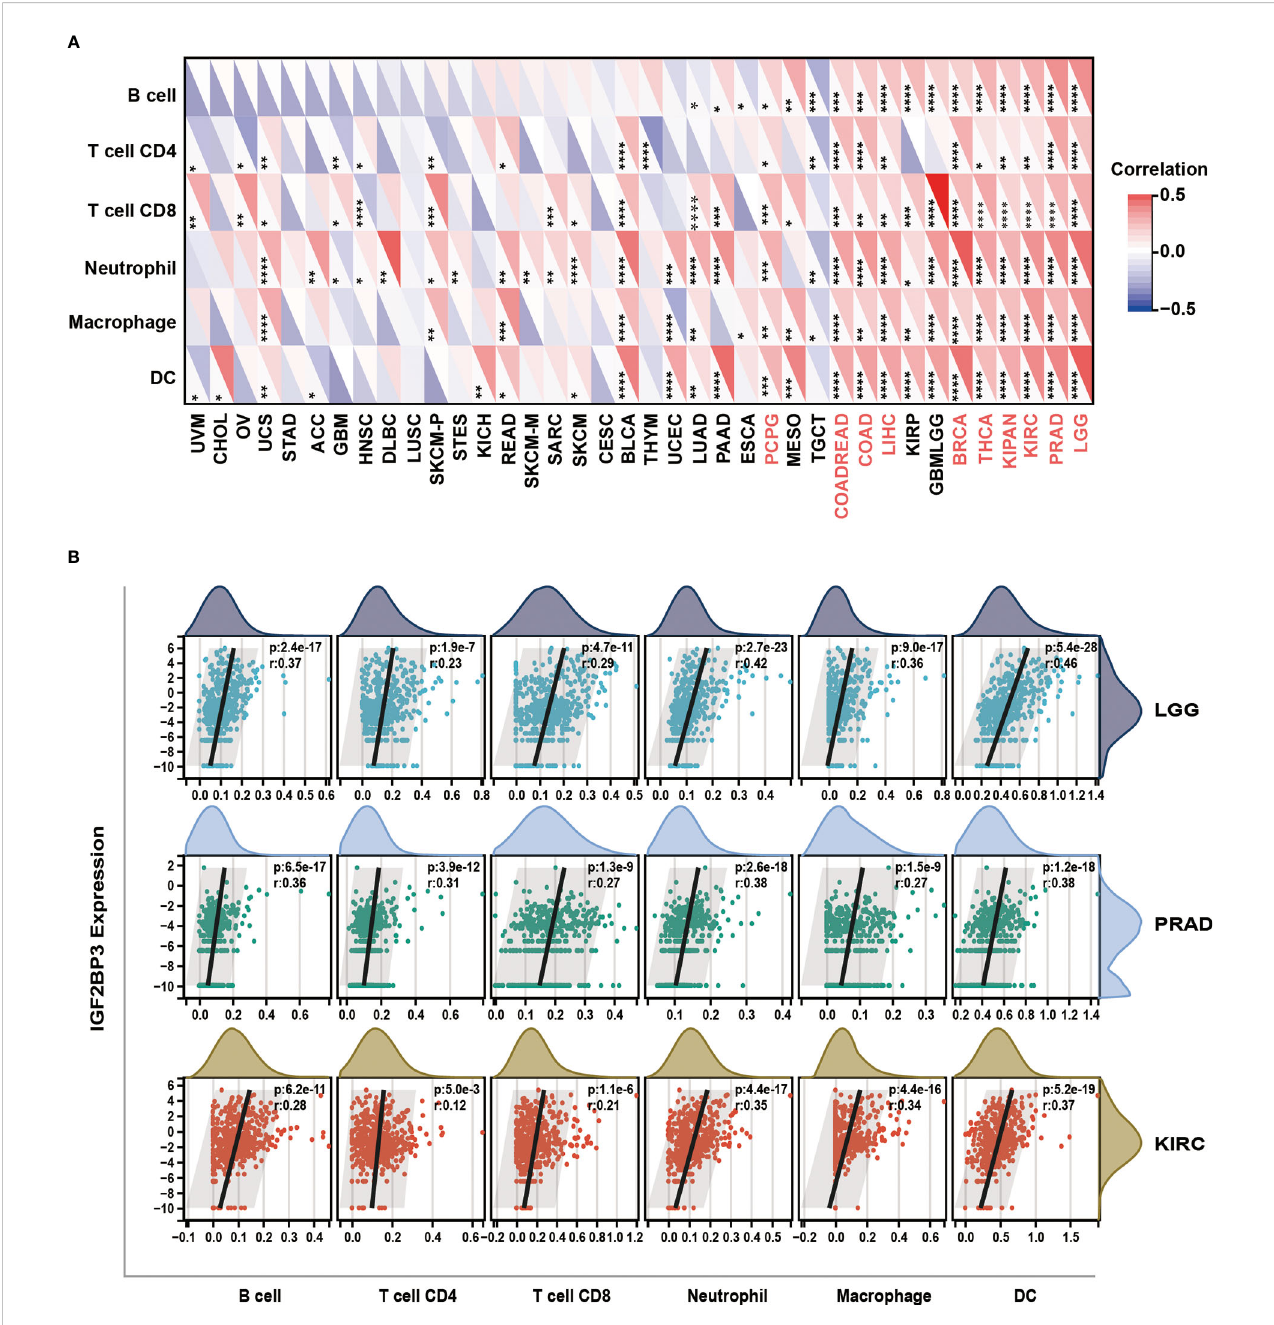
FIGURE 9 Relationship of IGF2BP3 expression with Immune cell in fi ltration analysis. (A) The relationship between IGF2BP3 expression levels and the levels of in fi ltration of six immune-related cells based on TIMER database. (B) Analysis of immune-associated cells in fi ltration with IGF2BP3 expression in pan-cancer. p ≥ 0.05; *p < 0.05; **p < 0.01; ***p <